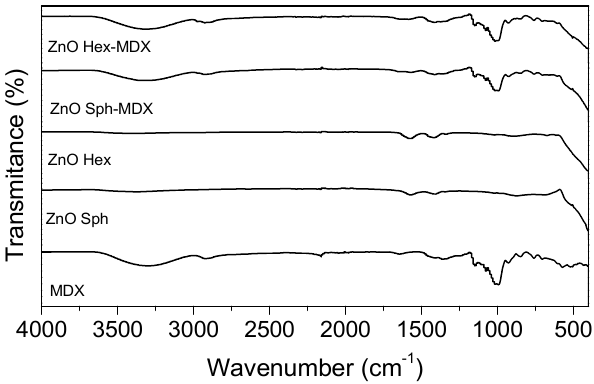
Figure 5. FT-IR spectrums of ZnO-NPs synthesized and modified by precipitation method.